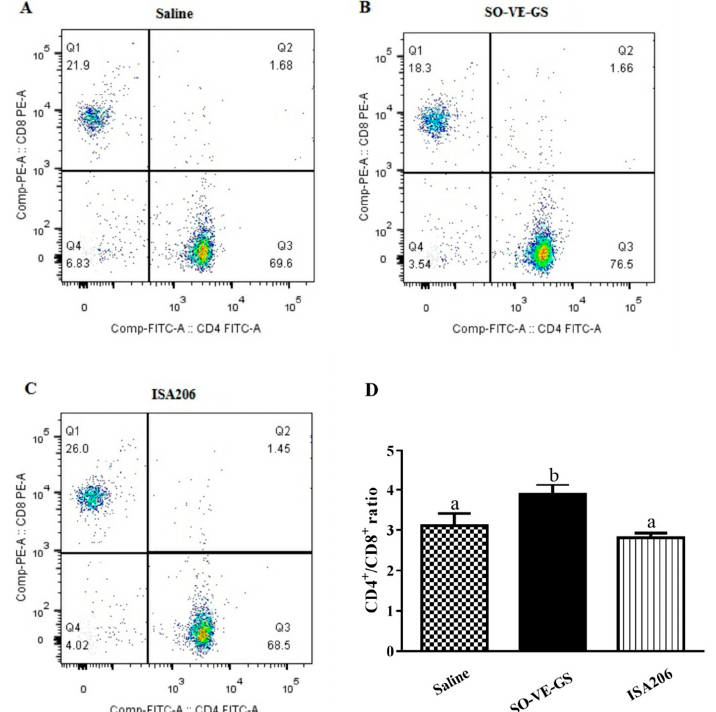
Figure 5. The CD4 + / CD8 + T cell ratio of the splenocytes. Mice ( n = 6 / group) were i.m. immunized twice at a 2-week interval with the FMDV antigen in saline or adjuvanted with SO-VE-GS or ISA 206. Splenocytes were isolated from the spleens harvested 2 weeks after the boost. Cells were labeled with fluorochrome-conjugated antibodies to CD3-APC, CD4-FITC, and CD8-PE and analyzed by flow cytometry. The representative flow cytometry dot plots were shown in ( A – C ) and the quantification of CD4 + / CD8 + ratio was shown in Figure ( D) . The values are presented as means ± SE. Bars with di ff erent letters are statistically different ( P < 0.05).